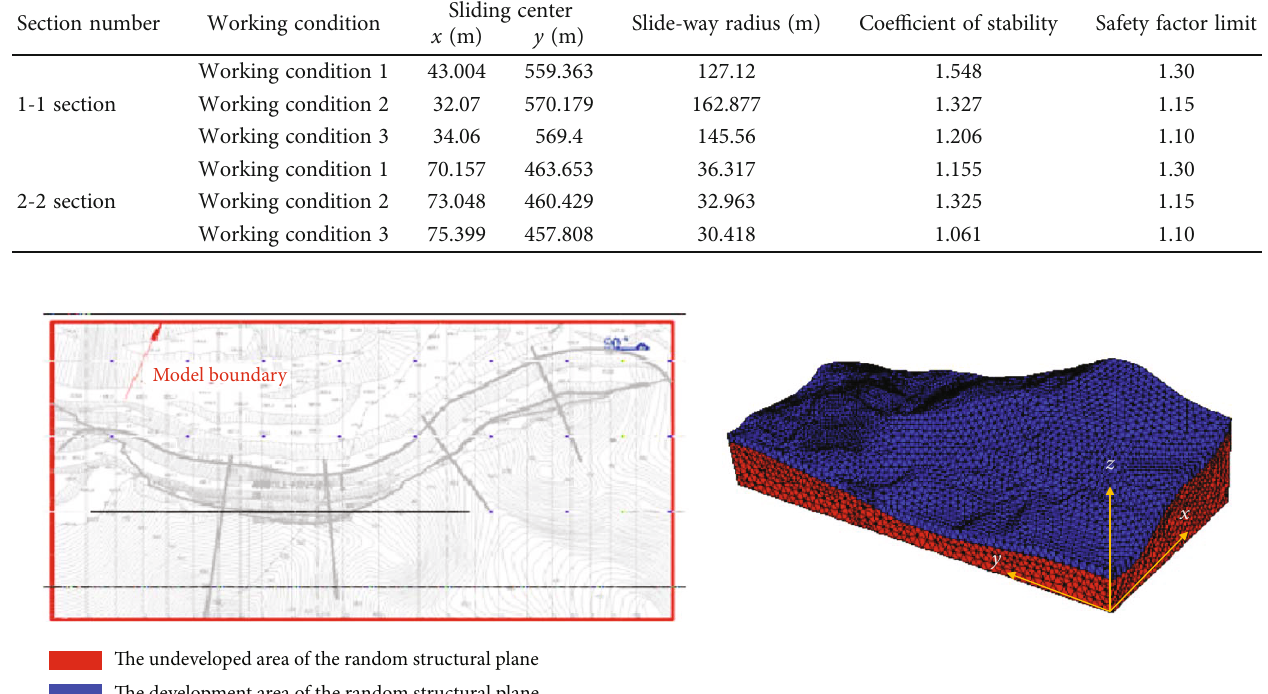
Figure 10: Schematic diagram of the 3D model and the mesh division of the